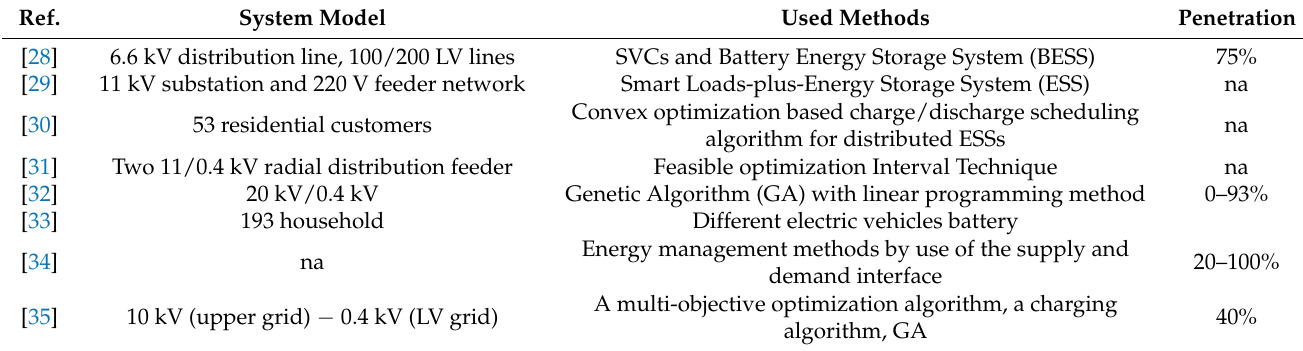
Table 1. Comparison analysis between researched